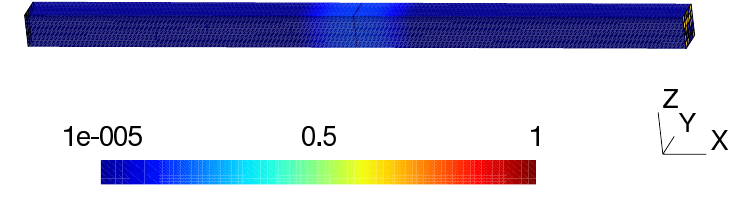
Figure 4. Error E (34) in % for the α = 0 ◦ discontinuity, h = L/ 500 , ρ/h = 5 and support = 20 ρ width ℓ ρ